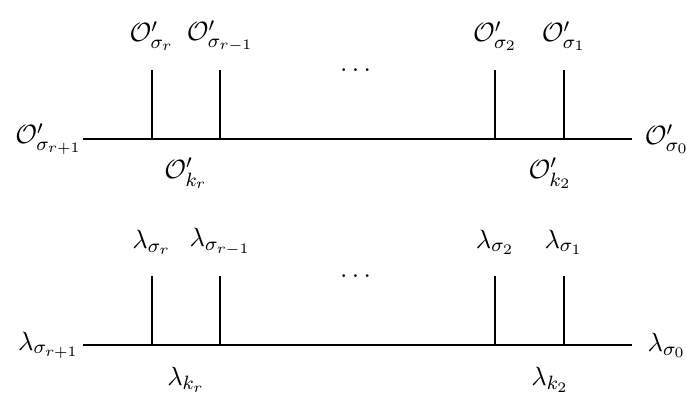
Figure 20 . The initial comb structure after removing all other comb structures in the ( M − 1) -point diagram. Here, it should be understood that σ either external or internal